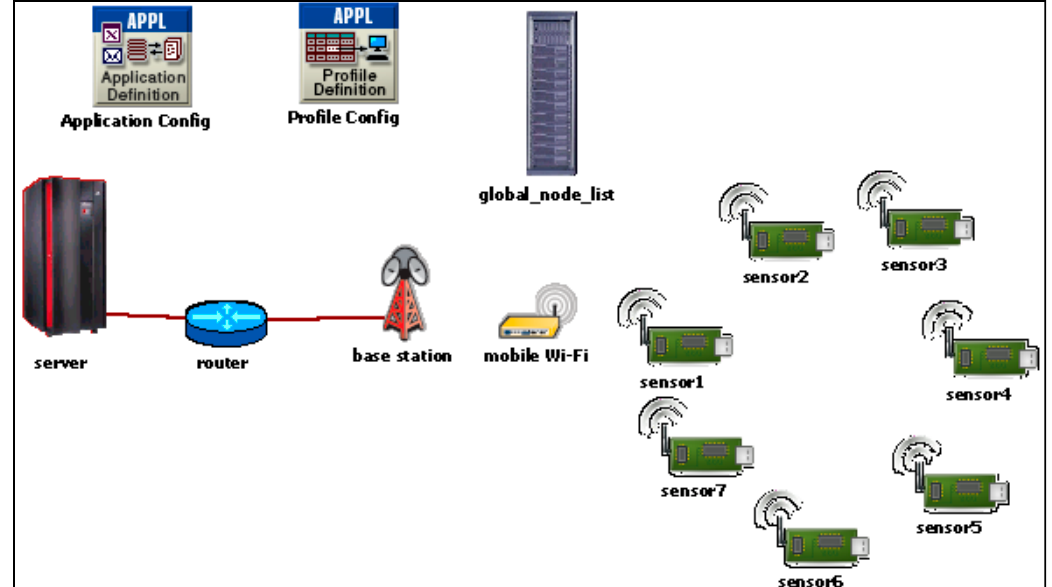
Figure 4. OPNET simulation environment [25].